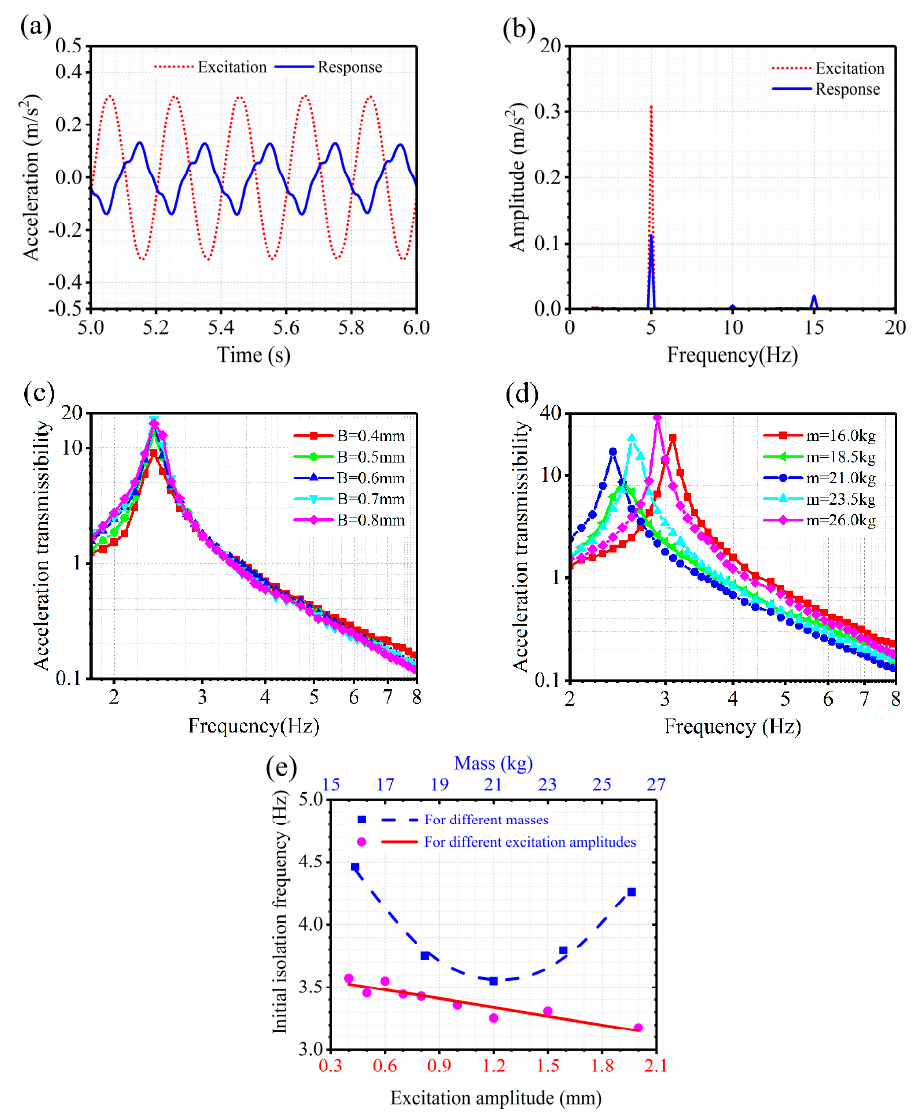
Figure 9. The results of discrete sinusoidal excitation experiment. ( a ) The time domain signal at 5 Hz with excitation displacement of 0.6 mm. ( b ) The frequency domain signal at 5 Hz with excitation displacement of 0.6 mm. ( c ) Acceleration transmissibility for different excitation amplitudes: m = 21 kg. ( d ) Acceleration transmissibility for different mass loads with excitation amplitude of 0.6mm. ( e ) The initial isolation frequency of the isolator.